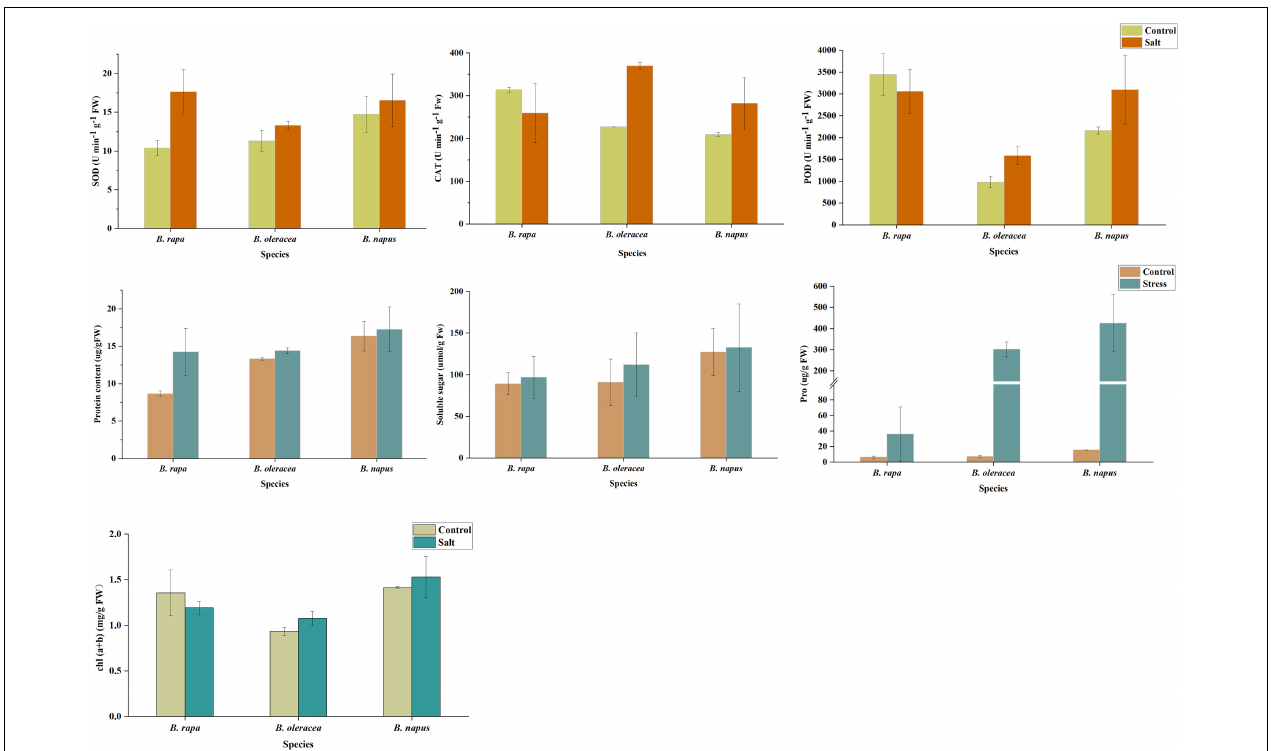
FIGURE 8 | The physiological responses of B. napus and diploid progenitors to salt